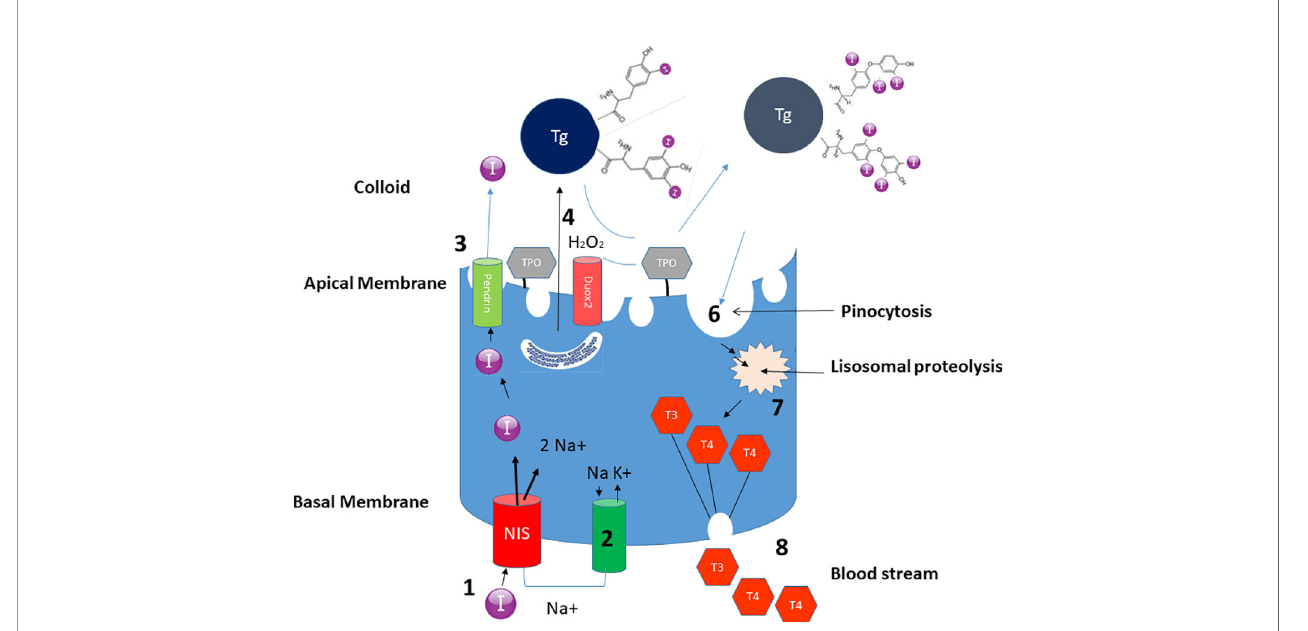
FIGURE 1 | Schematic representation of the role of iodine in the biosynthesis of thyroid hormones. Thanks to the action of NIS, iodine is incorporated in the thyrocyte (1). The process is guaranteed by the Na+ electrochemical gradient generated by the Na+/K+ ATPase on the basolateral membrane (2). Iodine subsequently crosses the apical membrane carried by pendrine (3) – and probably also by other transporters, to reach the colloid. Thyroglobulin, synthesized in the rough endoplasmic reticulum, reaches the colloid through exocytosis (4). The iodine present in the colloid is oxidized and incorporated in thyroglobulin, through the enzymatic mechanism of TPO thanks to H2O2 generated by Duox2 (5) Iodized thyroglobulin is internalized with a mechanism of pinocytosis (6) and undergoes proteolysis (7) giving rise to the formation of T4 and T3 which are then conveyed to the bloodstream